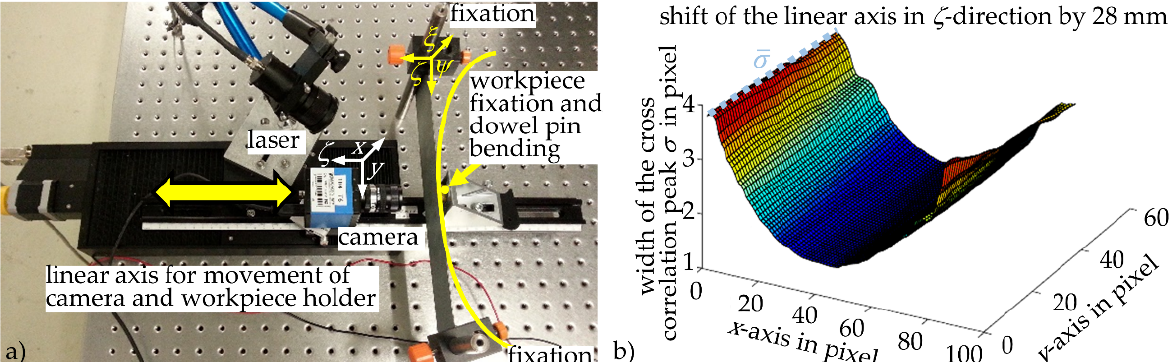
Figure 4. Speckle-photographic laboratory experiment: ( a ) laboratory setup with indicated bending of the workpiece sheet over a locating dowel pin (yellow) fixed in the camera system; ( b ) field of the respective local widths of the correlation functions, at a linear axis displacement of 28 mm.